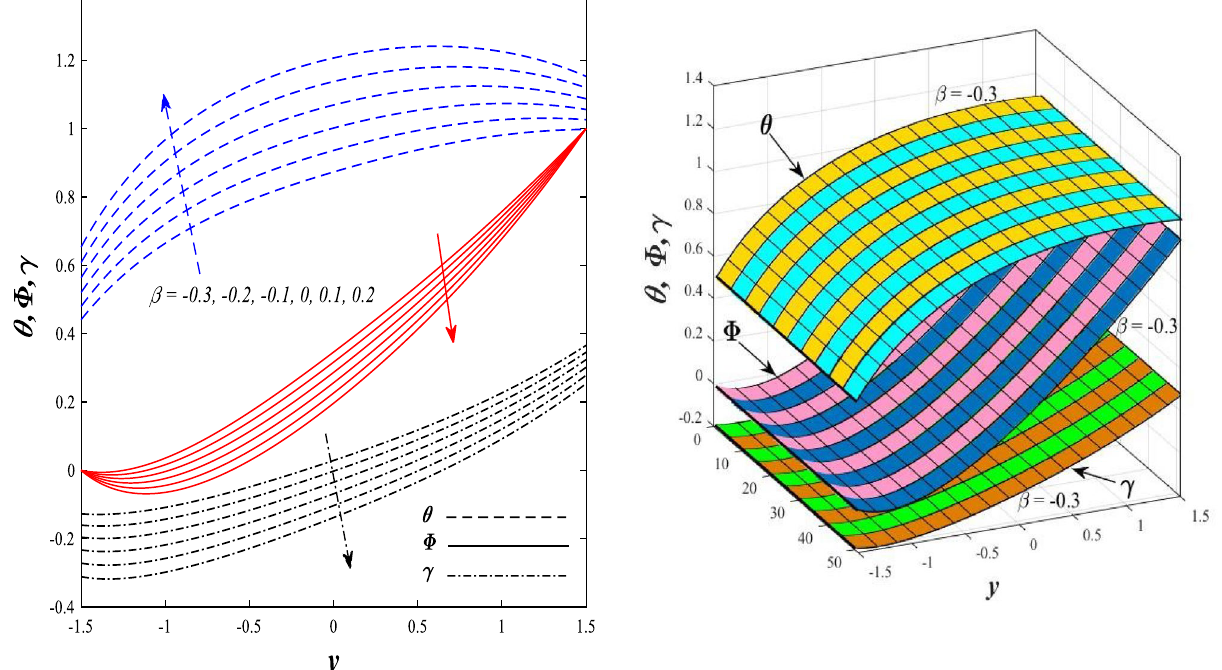
Figure 11. Effect of heat generation/absorption parameter β on the distributions of both temperature, solutal concentration and nanoparticles volume fraction 2D and 3D.